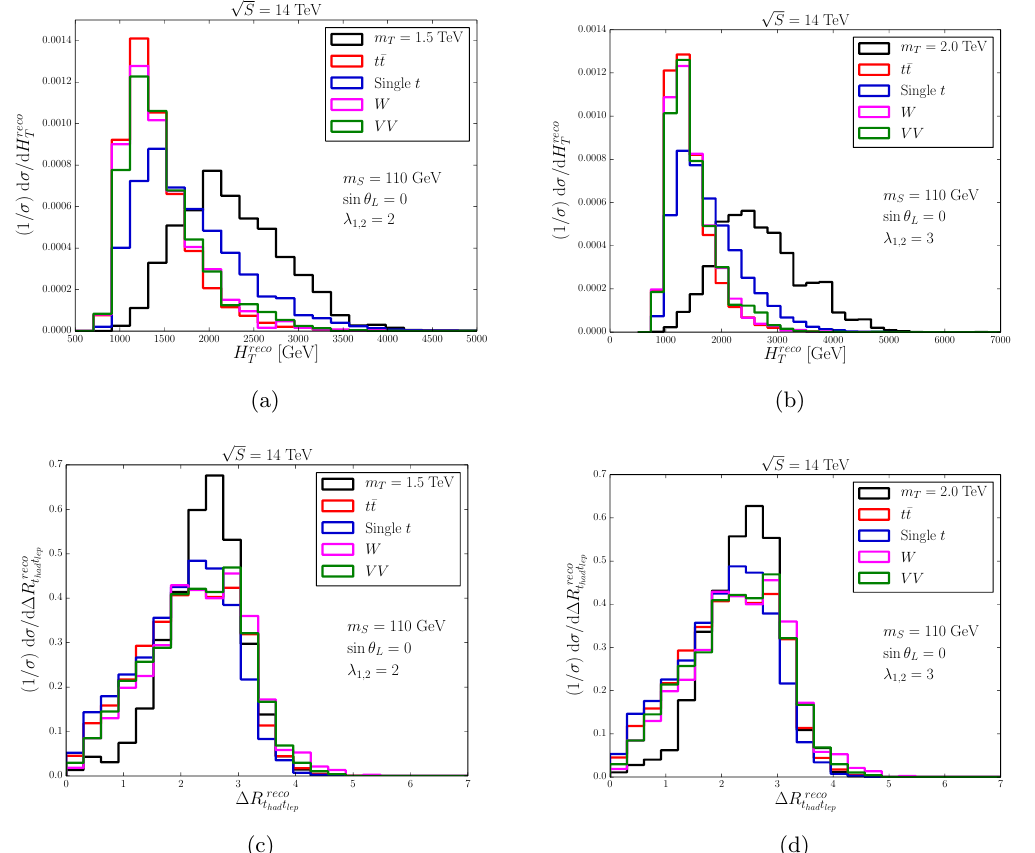
Figure 19 . (a,b) H reco , eq. (6.31), distributions are shown for (a) m T = 1 : 5 TeV and (b) m T = T 2 TeV. (c,d) Distributions of the angular separation between the two reconstructed top quark, (cid:1) R reco are shown for (c) m T = 1 : 5 TeV and (d) m T = 2 TeV. All plots are generated based on t had t lep events after showering, hadronization, and detector e(cid:11)ects. The other model parameters are set to m S = 110 GeV and sin (cid:18) L = 0. The coupling constants are (cid:21) 1 ; 2 = 2 for m T = 1 : 5 TeV and (cid:21) 1 ; 2 = 3 for m T = 2 TeV. Basic cuts in eqs. (6.8){(6.11) have been applied.